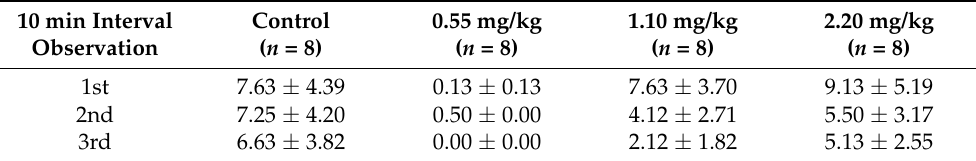
Table 5. Intromission frequency of male rats treated with M. oleifera leaf tea and the control group observed in the first, second and third 10 min interval over 30 min period.